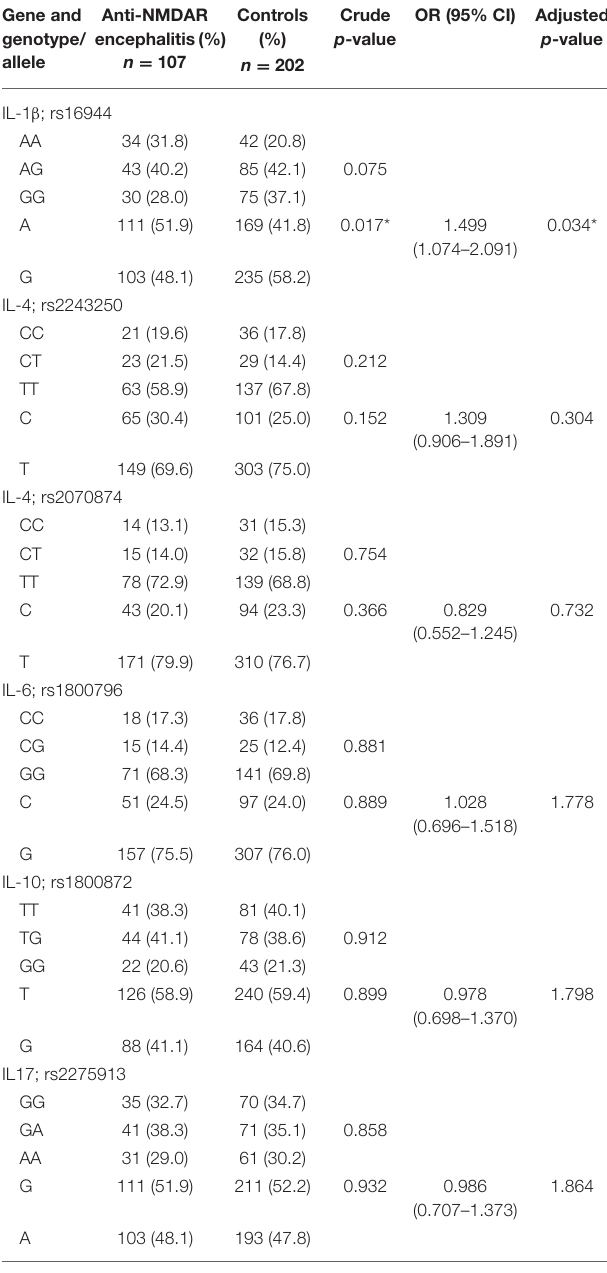
TABLE 1 | Genotype and allele frequencies of IL-1 β , IL-4, IL-6, IL-10, and IL-17 in anti-NMDAR encephalitis and control groups. Gene and